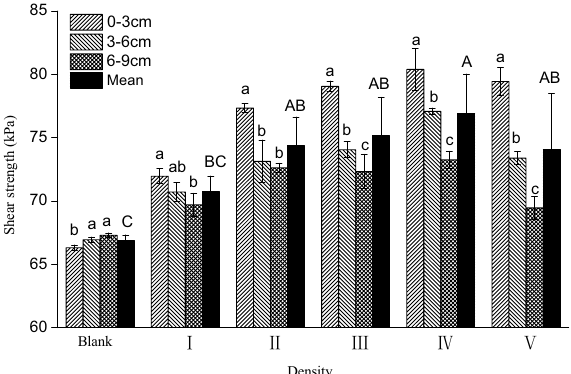
Figure 3. Shear strength of E. nutans root–soil composites under different plant density treatments. Lowercase letters indicate statistically significant (p < 0.05) differences between soil layers at different depths within the same plant density treatments. Capital letters indicate statistically significant (p < 0.05) differences between different plant density treatments.